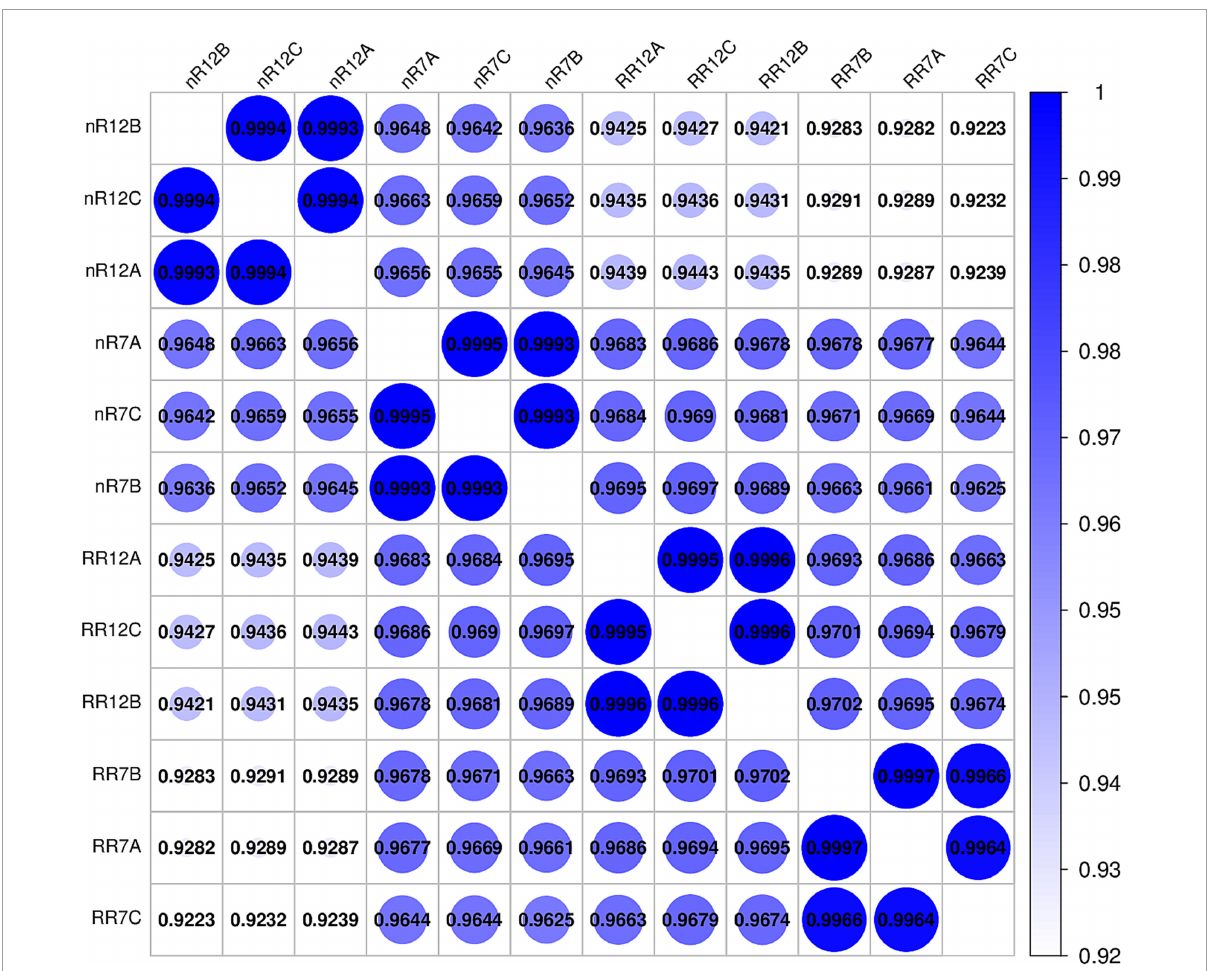
FIGURE2 The heat map of the correlation coefficient between different samples, including nR7, RR7, nR12, and RR12 represents the 70 DAP and 125 DAP sampling points under nR and RR cultivation. The specific correlation value was reflected on the